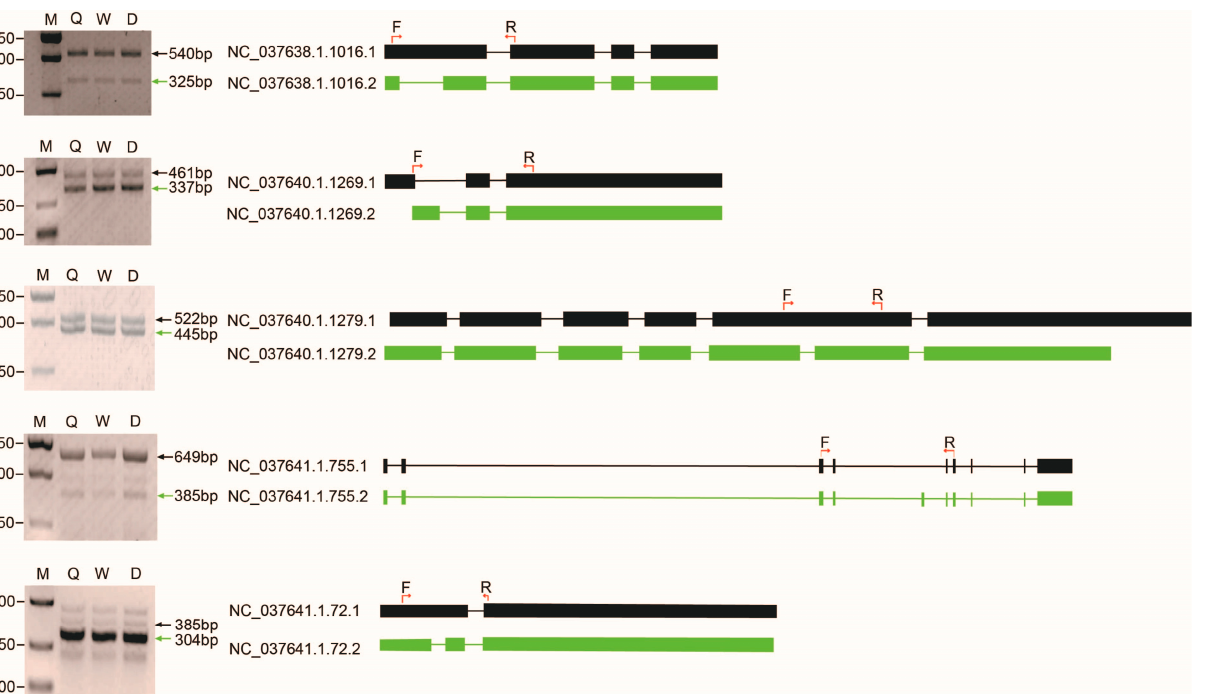
Figure 3. The alternative splicing events identified from PacBio honey bee transcriptome. ( A ) Dis- tribution of splice isoforms of genes. ( B ) The exon/intron structure of the six isoforms of the Mob3 gene. The filled boxes represent exons and lines represtent introns. The isoform in red was obtained by genome annotation. ( C ) The comparison of each alternative splicing type between this PacBio data and the NCBI reference transcript set.